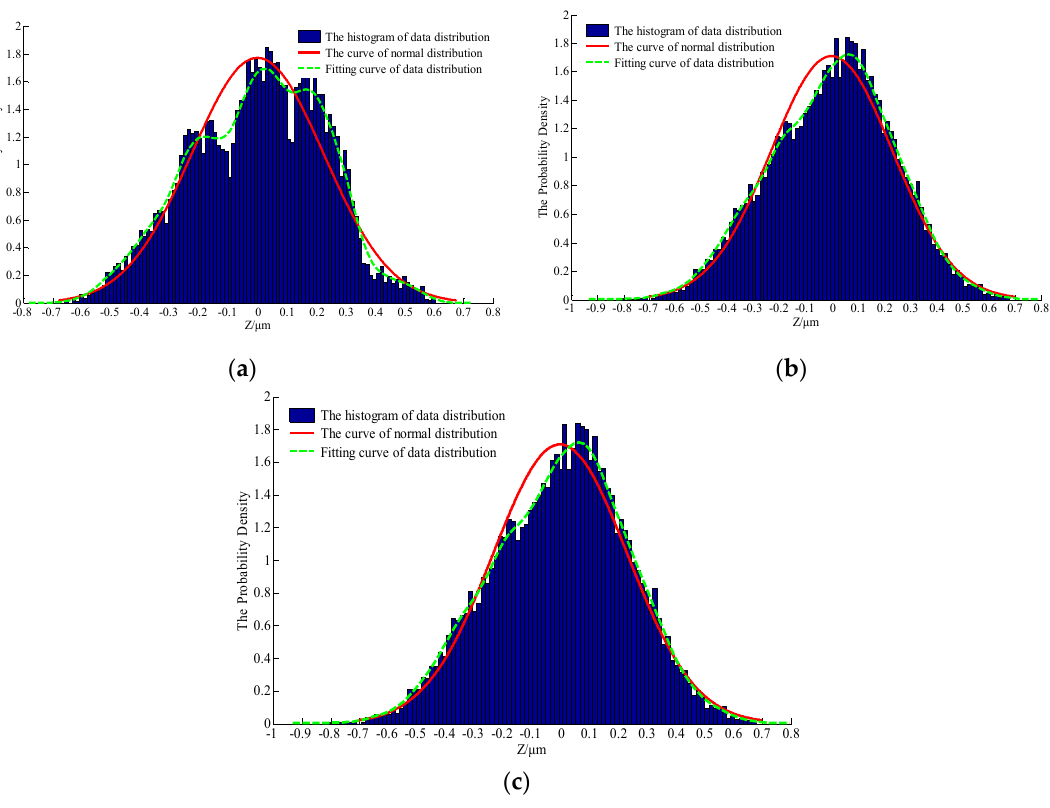
Figure 11. The probability density for different D and G : ( a ) D = 1.5, G = 0.12; ( b ) D = 1.7, G = 0.12; ( c ) D = 1.5, G = 0.52.